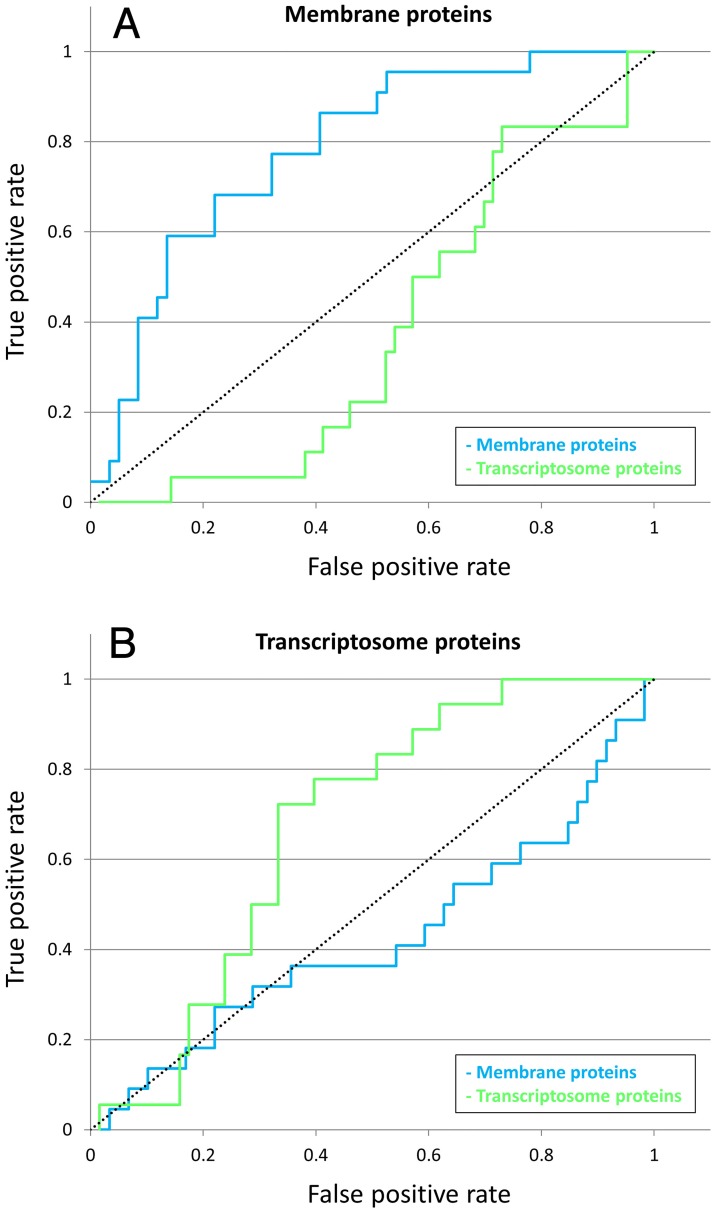
‘Biological rationality’ in the dataset, as ROC (‘receiver operating characteristic’) curves.Proteins with strong functional annotations were divided into functional groups (Table 3) and on this basis were subjected to ROC analysis (Materials & methods). Briefly, a listing of all virion proteins with crosslinking partners was ranked by proportion of partners that were classed as: (a) membrane, (b) transcriptosome. ROC curves score, proportionately (0 to 1), positions (y) vs. not(positions) (x) in the ranking that correspond to membrane proteins (blue) or transcriptosome proteins (green). The line of no-discrimination (neutrality) is shown black, dotted. A colored line curving above the diagonal indicates a positive correlation, and vice versa.